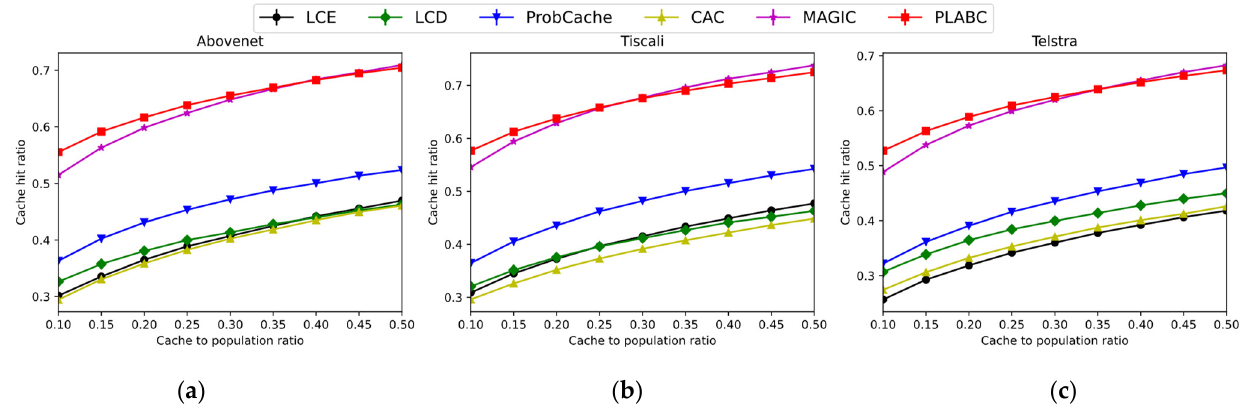
Figure 11. Cache hit ratio results of different caching strategies when the relative cache size varies under topology: ( a ) Abovenet; ( b ) Tiscali; ( c ) Telstra.